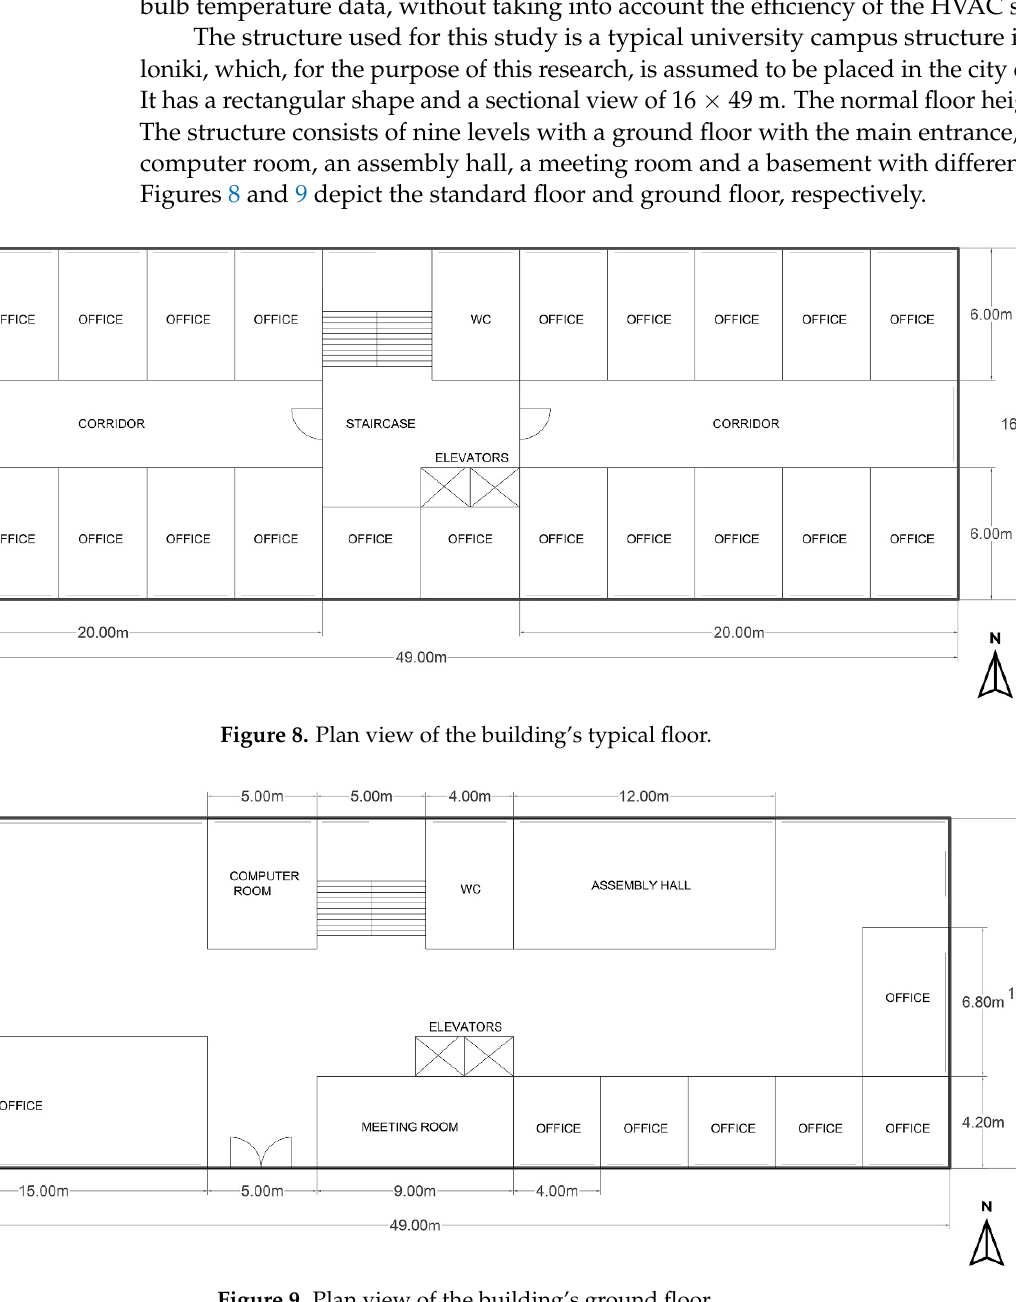
Figure 9. Plan view of the building’s ground floor.